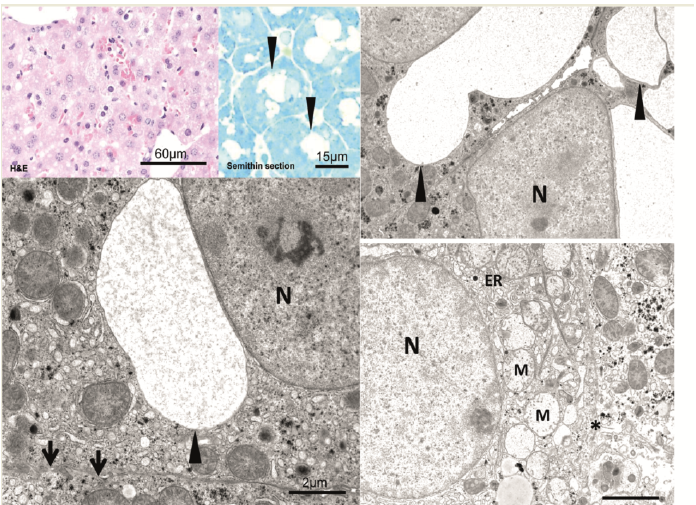
Figure 4. After 10 to 20 min, vesicles increase in size and number, often forming vacuoles (arrow- heads). Vacuoles can usually be found in proximity to the nucleus (N). They are optically empty and contain no electron-dense material. Vesicle-containing hepatocytes show intact cell borders (arrow). In contrast, some but other hepatocytes reveal signs of cell damage, i.e., swollen mitochondria (M), dilated endoplasmic reticulum (ER), and disrupted plasma membranes (asterisk). All findings were similar after the injection of the empty vector and the saline solution as well. Scale bars are indicated in the respective image.